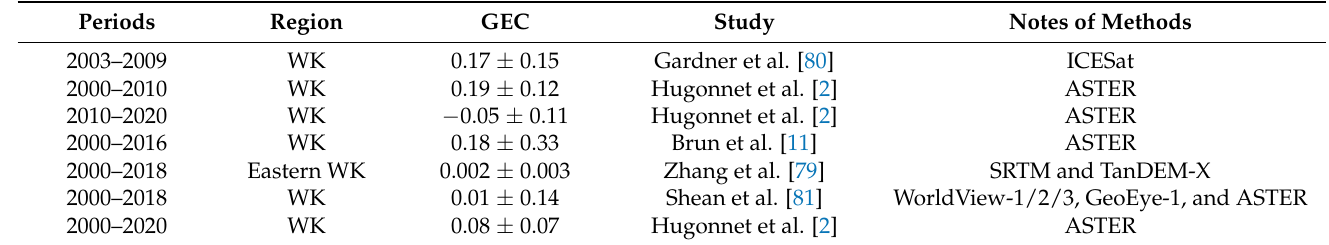
Table 4. Averaged glacier elevation change (GEC), in a unit of m a − 1 , comparing our results and others.